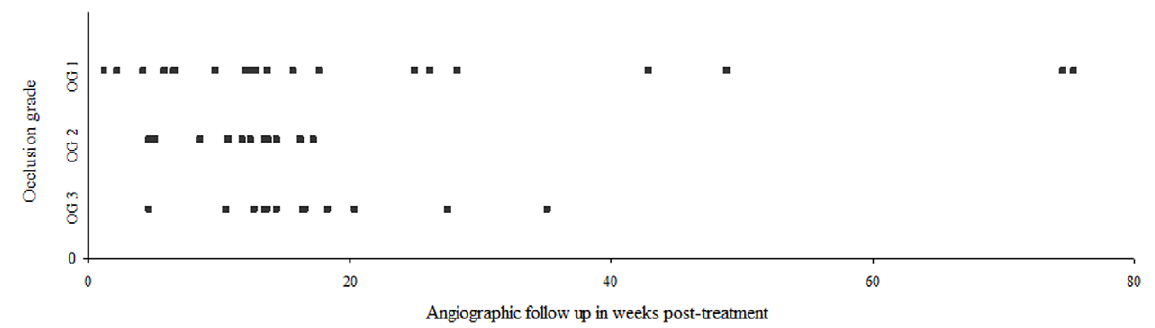
Figure 3. Timings and results of angiographic follow up. Plot of angiographic outcomes against follow up times in weeks. doi:10.1371/journal.pone.0012492.g003 PLoS ONE |